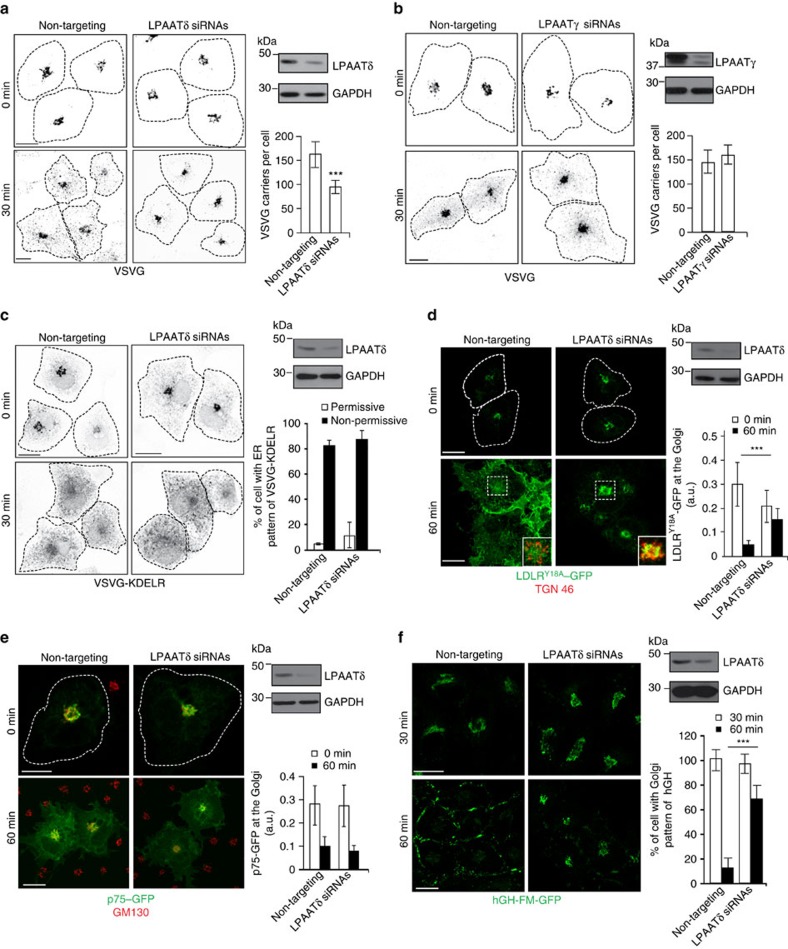
LPAATδ is required for the fission of basolaterally-directed carriers.(a,b) Representative images of COS7 cells treated with non-targeting and LPAATδ siRNAs in a or LPAATγ siRNAs in b before VSV infection and the TGN-exit assay with 0.5% tannic acid. The cells were fixed following a 20 °C block (0 min) or 30 min after the shift to 32 °C, and stained for VSVG-positive post-Golgi carriers. Quantification is on the right (see Methods). (c–e) Representative images of COS7 cells treated with non-targeting and LPAATδ siRNAs before co-transfection for the last 16 h with VSVG-ts045-KDELR-myc in c or with the endocytosis-defective LDLR–GFP receptor in d or with a plasmid encoding p75–GFP in e. (c) The distribution of the chimeric KDELR was examined following the shift to the non-permissive temperature for 30 min. Quantification of ER distribution of the chimeric KDELR (right). (d) Following the 2 h at 20 °C transport block (0 min) and 60 min after the shift to 32 °C (with cycloheximide), the cells were fixed and labelled with TGN46 (Golgi marker; red). Insets: enlarged view of merged signals for the Golgi area. (e) Following the 3 h at 20 °C block (0 min) and 60 min after the shift to 32 °C (with cycloheximide), the cells were fixed and stained for GM130 (Golgi marker; red). (d,e) Quantification of LDLRY18A–GFP in d and p75–GFP in e in the Golgi area (right). (f) Representative microscopy of HeLa cells stably transfected with hGH-FM–GFP and treated with non-targeting and LPAATδ siRNAs before subjection to a secretion assay. Release of hGH-FM–GFP from ER was performed by the addition of DD-solubilizer at 37 °C for the indicated times. Quantification of hGH-FM–GFP in the Golgi area (right). (a–e), Dotted lines indicate cell borders. (a–f), The efficiency of interference was monitored by western blotting of the cell lysates using polyclonal anti-LPAATδ in a,c–f, or polyclonal anti-LPAATγ in b antibodies. Glyceraldehyde 3-phosphate dehydrogenase (GAPDH) is shown for the internal protein levels and molecular weight standards (kDa) are indicated on the left of each panel in a–f. Data are means±s.d. of three independent experiments. ***P<0.005 (Student's t-tests). Scale bars, 10 μm.